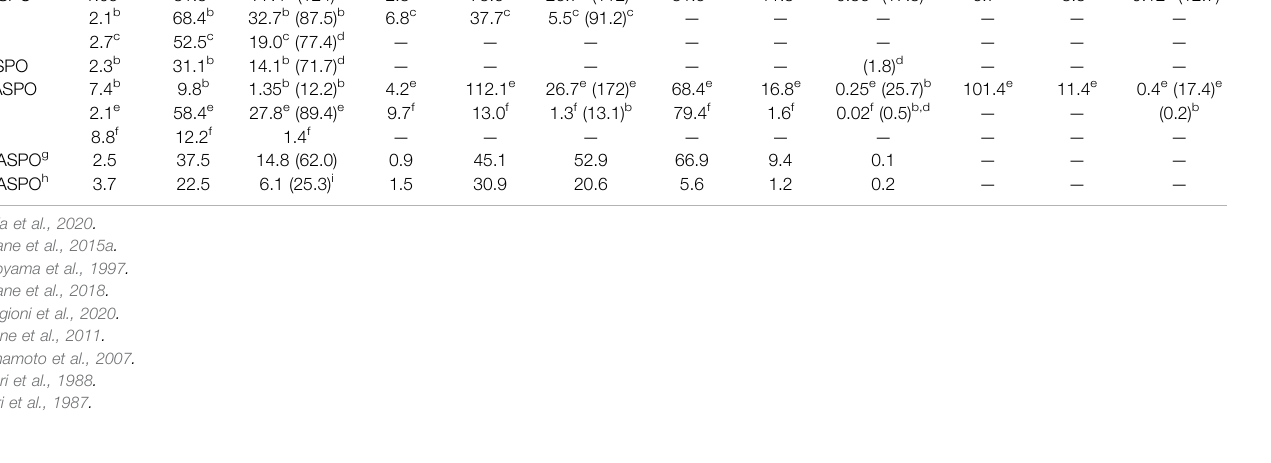
TABLE1| ComparisonofapparentkineticparametersofmammalianDASPOsonselectedsubstrates(determinedat21%oxygensaturation).Inparenthesisisreportedthe speci fi c activity value (as U/mg protein). D-Asp NMDA D-Glu D-Asn